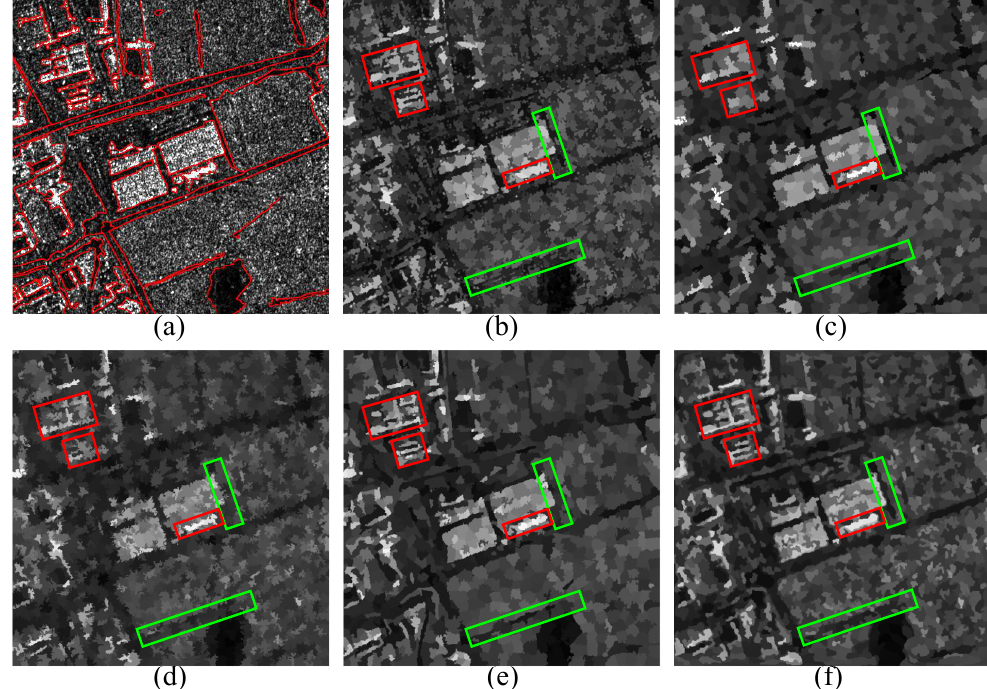
Figure 12. Superpixel generation results of the five methods for the C-band SAR image. ( a ) Ground truth. ( b ) SRMP. ( c ) MISP. ( d ) LSC. ( e ) ESOM. ( f ) ML-SGN.